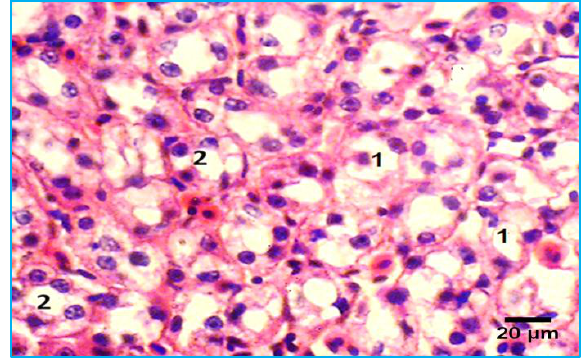
Figure, 5: The medullary cone shows: Thin segment of loop of Henle (1) and thick segment of loop of Henle (2). (H and E-phloxine stain).